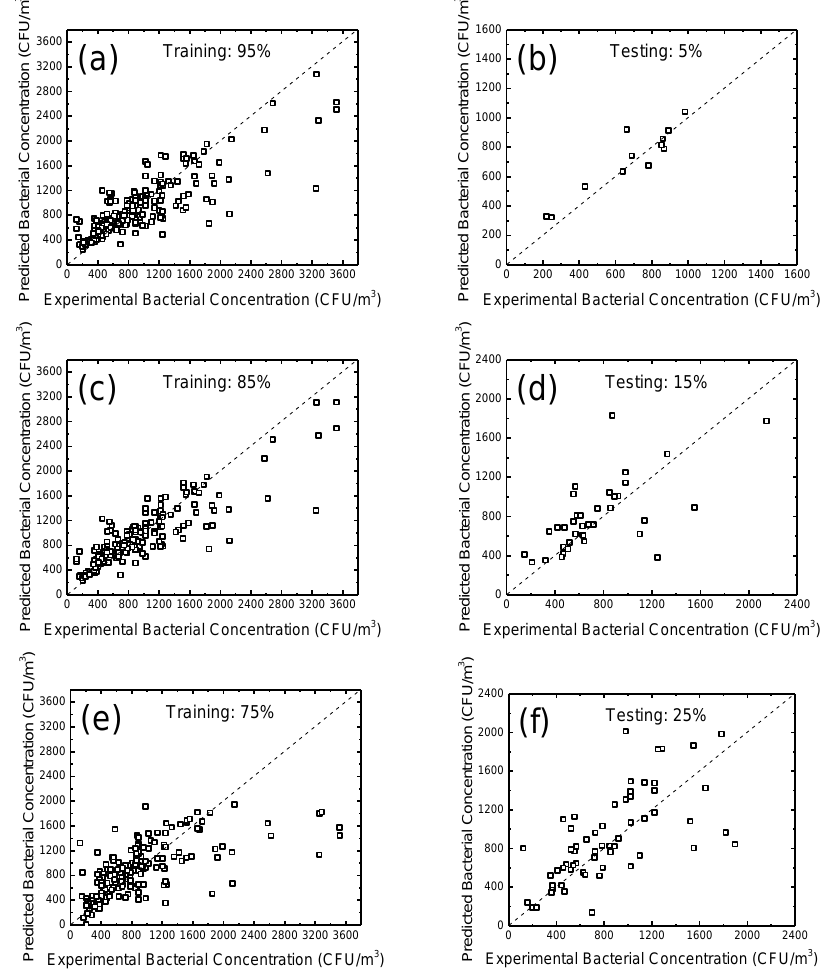
Figure 3. Typical comparative results of predicted bacterial concentration vs. experimental bacterial concentration in various percentages of training and testing sets. ( a , b ) Training and testing results with the training and testing percentages of 95% and 5%, respectively. ( c , d ) Training and testing results with the training and testing percentages of 85% and 15%, respectively. ( e , f ) Training and testing results with the training and testing percentages of 75% and 25%, respectively. Diagonals represent the function of y = x